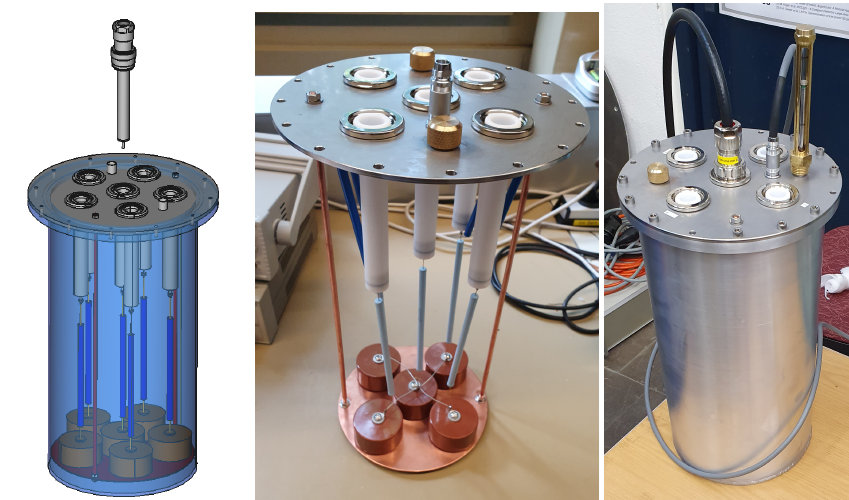
Figure 12. Left: CAD drawing of the PFD-5 Potted Filter-Distributor. The electrical connection between the capacitors at the bottom is omitted for image clarity. Middle: Assembly of the prototype PFD-4 for 2 2 Demonstrator. Right: PFD-4 being tested at 60 ×